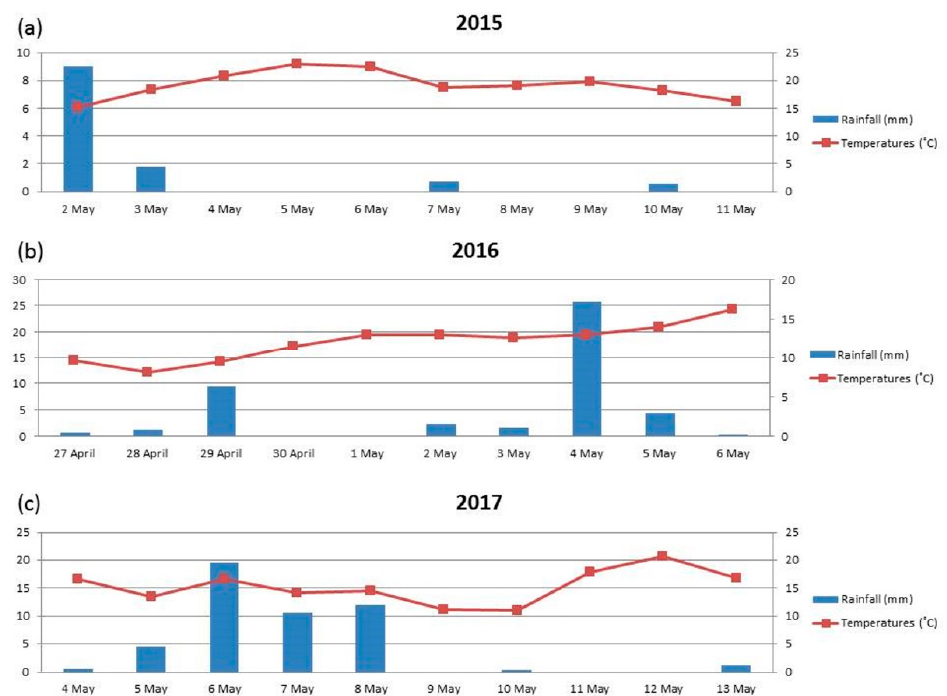
Figure 1. Climate diagrams for the vegetation seasons 2014/2015 ( a ), 2015/2016 ( b ), and 2016/2017 ( c ) in Osijek, Croatia.